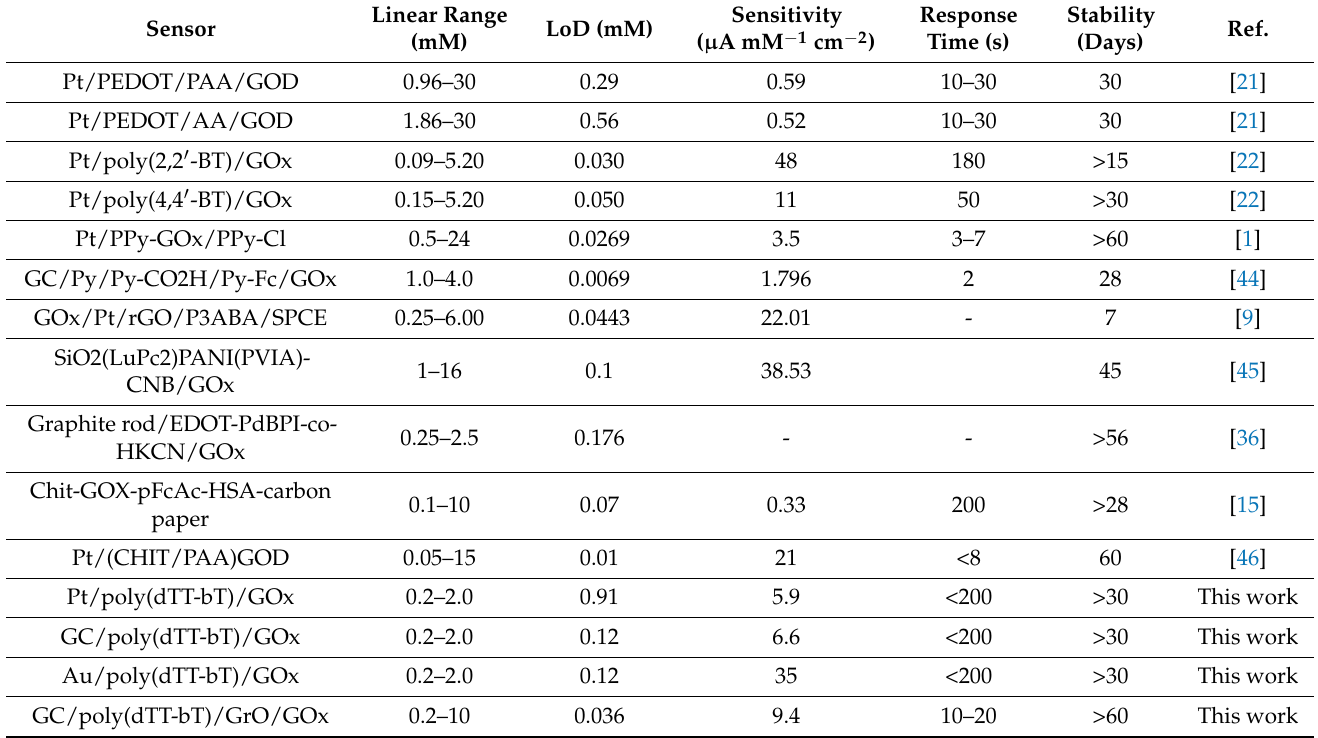
Table 3. Some examples of electrochemical GOx-based sensors for the determination of